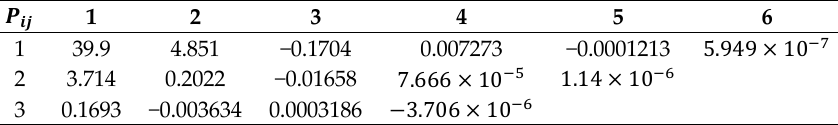
Table 2. Coefficients of the solubility polynomial